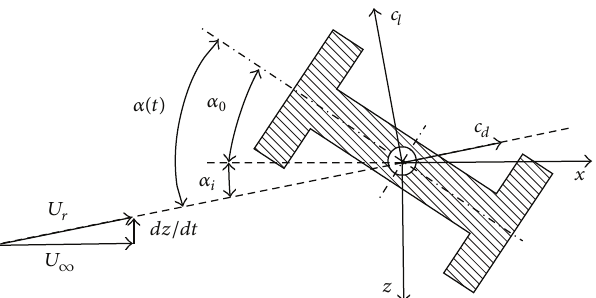
Figure 1: Sketch of a typical H beam. 𝑈 ∞ is the unperturbed upstream flow velocity, 𝑑𝑧/𝑑𝑡 is the vertical velocity due to transver- sal body oscillation, 𝛼 is the angle of attack of the body under static conditions, and 𝛼(𝑡) is the actual one. Lift and drag coefficients are 𝑐 𝑐 𝑙 and 𝑑 , respectively.